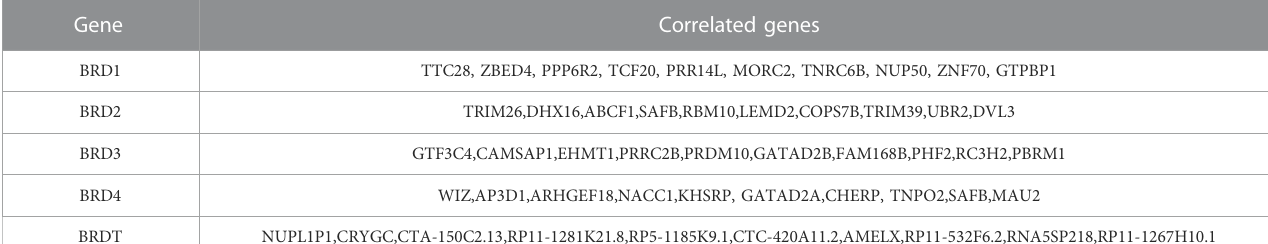
TABLE 1 The top 10 signi fi cant genes correlated with differentially expressed BET genes in GBM (GEPIA). Gene Correlated